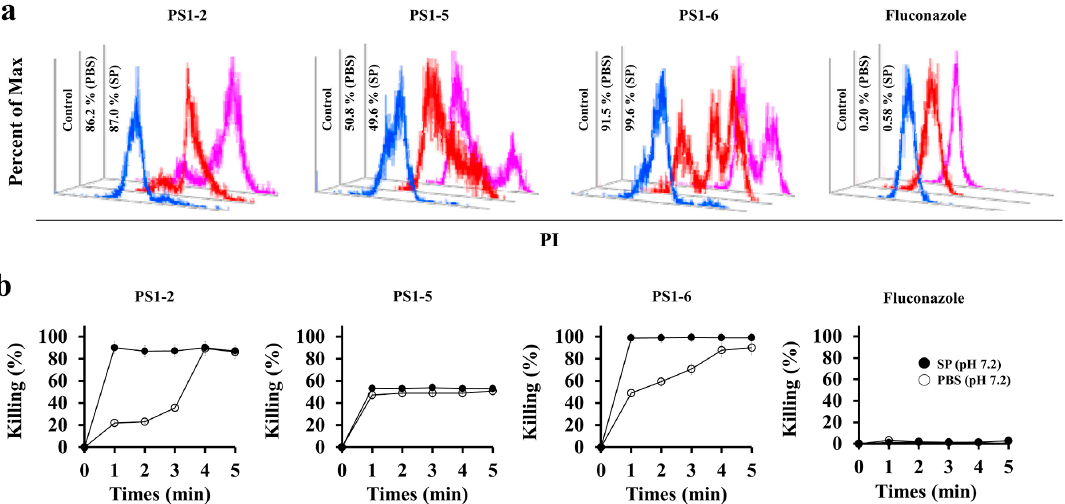
Figure 1. Time-kill kinetic activity of PS1-2, PS1-5, PS1-6, and fluconazole against drug-resistant C. albicans . ( a , b ) After incubation of each peptide and fluconazole in PI-pretreated C. albicans cells, dead cells were measured using flow cytometry. ( a ) presents the overlay spectra after 5 min incubation. ( b ) presents killing-percentages at 1 min intervals for 5 min (n = 4). Data are normalized to non- treated